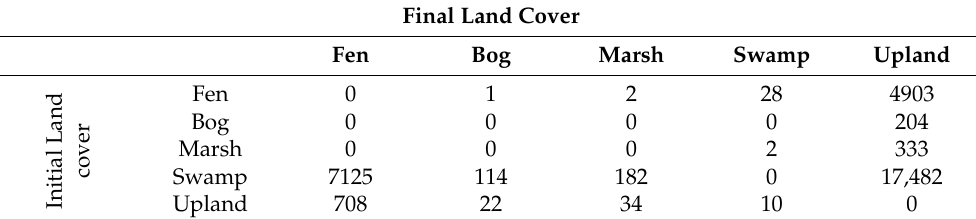
Table 9. Matrix showing pixel assignments by the proposed ensemble classifier in comparison with Classifier #1 (the traditional method) for a subset of the pixels shown in Table 7. For the pixels shown here, the correct class had the second largest support from the evidence, but the largest and second largest mass functions were similar. Columns are the land covers that a misclassified pixel was first assigned to from Classifier #1. The rows correspond to the land cover that a pixel was assigned to by the ensemble